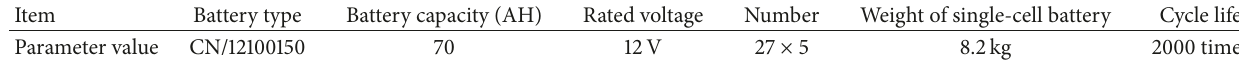
Table 5: Single-cell lithium battery parameters.